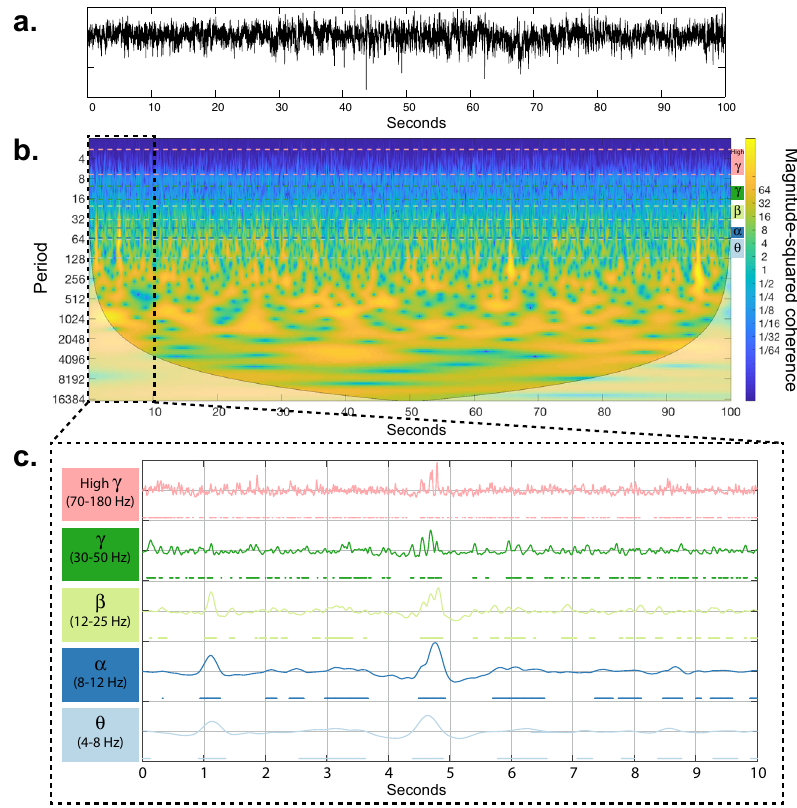
Fig. 1 Construction of power amplitude states from iEEG time-series. a The raw iEEG time-series recorded from a sample electrode. b A wavelet decomposition of 100 s of raw iEEG time-series 81 . Color-coded dashed lines show the θ , α , β , γ , and high γ frequency bands. c The average power of all frequencies within each band is high-pass fi ltered at 0.5 Hz, and normalized to obtain a z -score. The resultant time series were then thresholded at zero separately for each band, to create the binarized power amplitude states on which the MEM operates. Note that the ‘ on ’ states are marked by color-coded dots under each